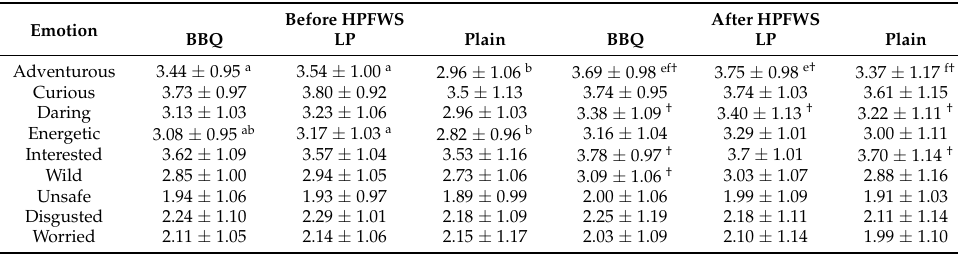
Table 6. Emotion intensities (mean ± standard deviation from a 5-point scale) related to catfish skin chips before and after HPFWS 1